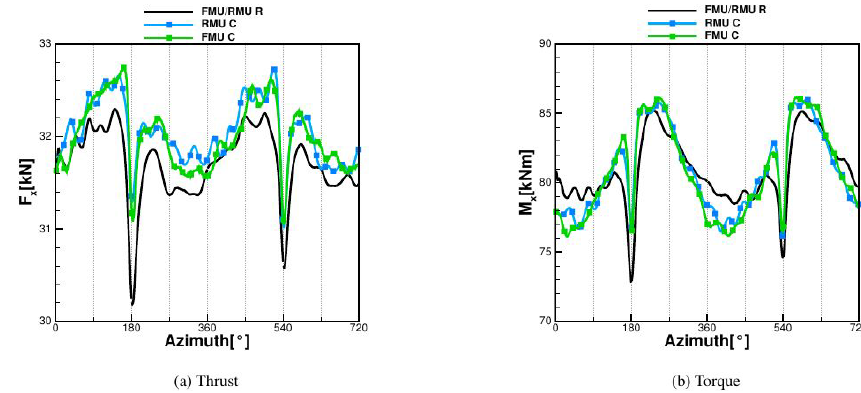
Figure 10. Thrust and torque calculated with CFD at 6.1ms − 1 comparing RMU vs. FMU, both rigid (R) and coupled (C).